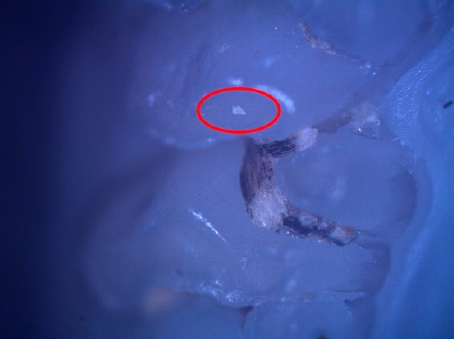
Figure 2. Hypomineralization lesion (surrounded by the red oval) on the occlusal surface of 26.